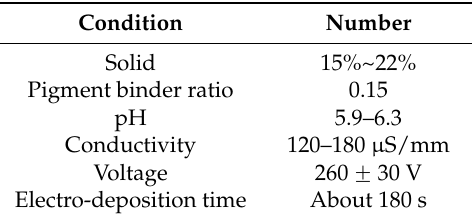
Table A1. Conditions of